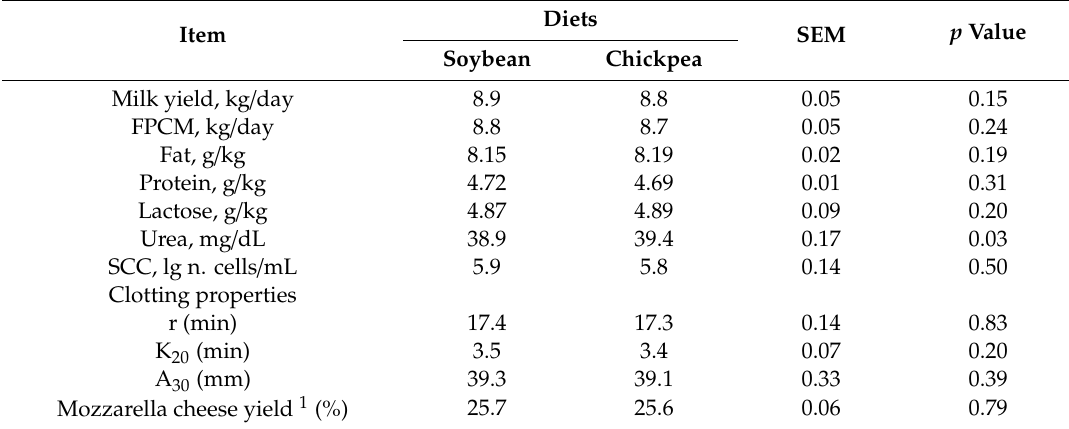
Table 4. E ff ect of diets containing soybean meal and chickpea meal as main protein source on daily milk yield and composition, milk-clotting properties, and estimated mozzarella cheese yield (Least Square